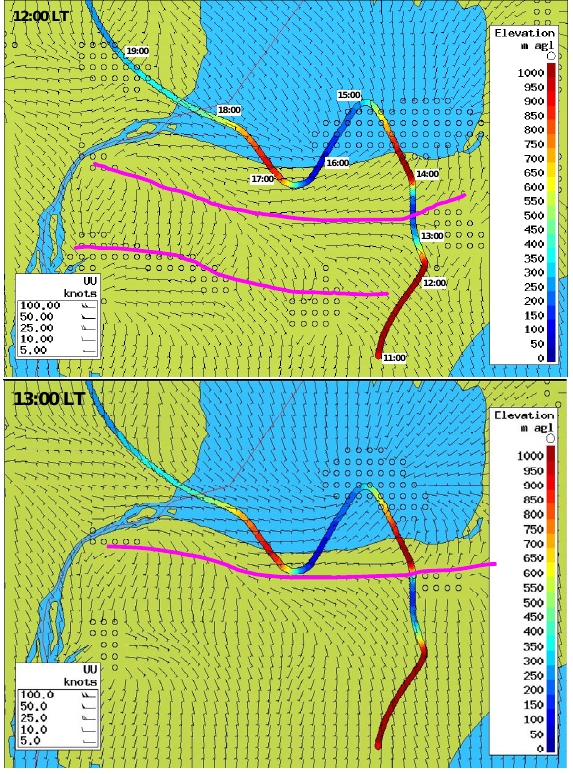
Fig. 9. Forward air parcel trajectory overlaid on the 285ma.g.l. model wind fields at (a) 12:00LT and (b) 13:00LT.